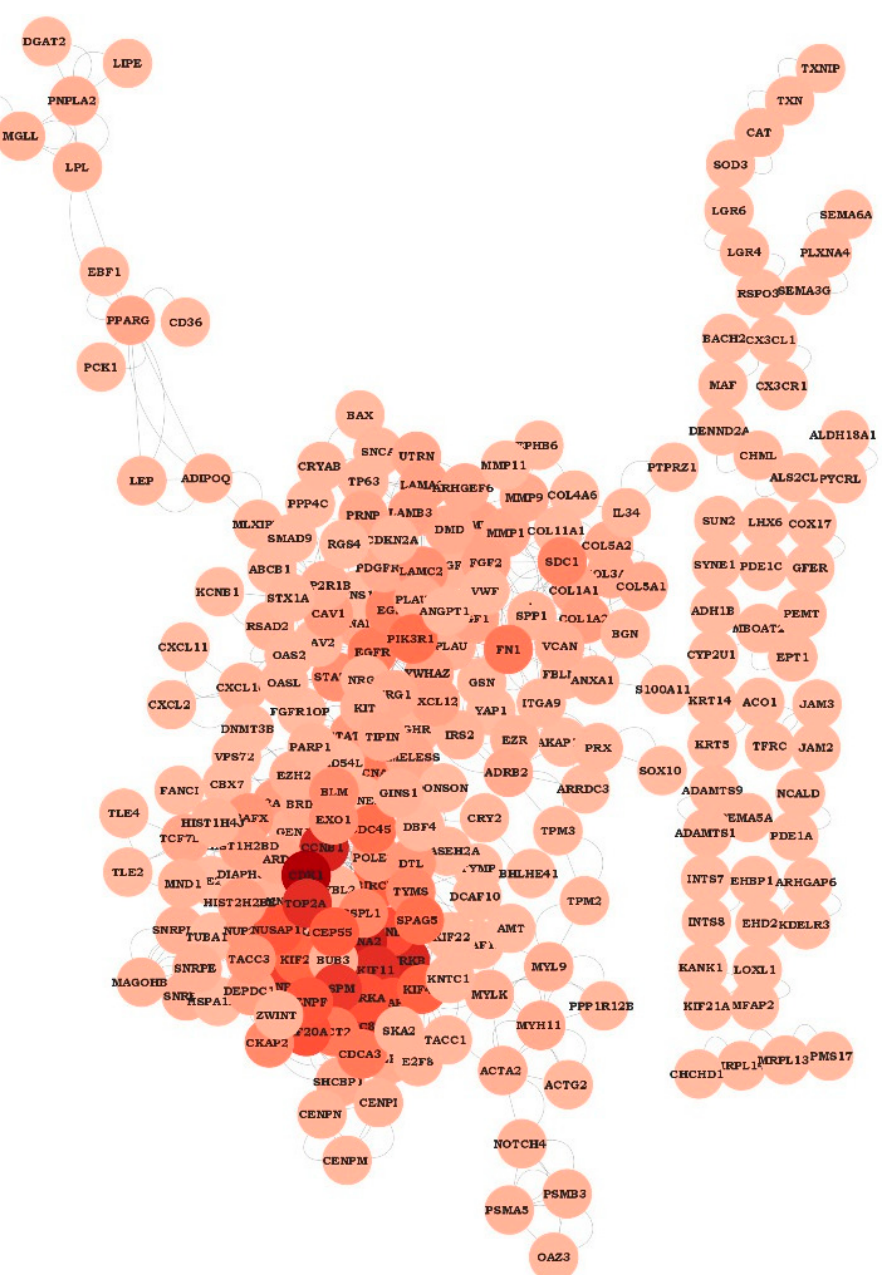
Figure 4. Full PPI network of the differentially expressed breast cancer genes.